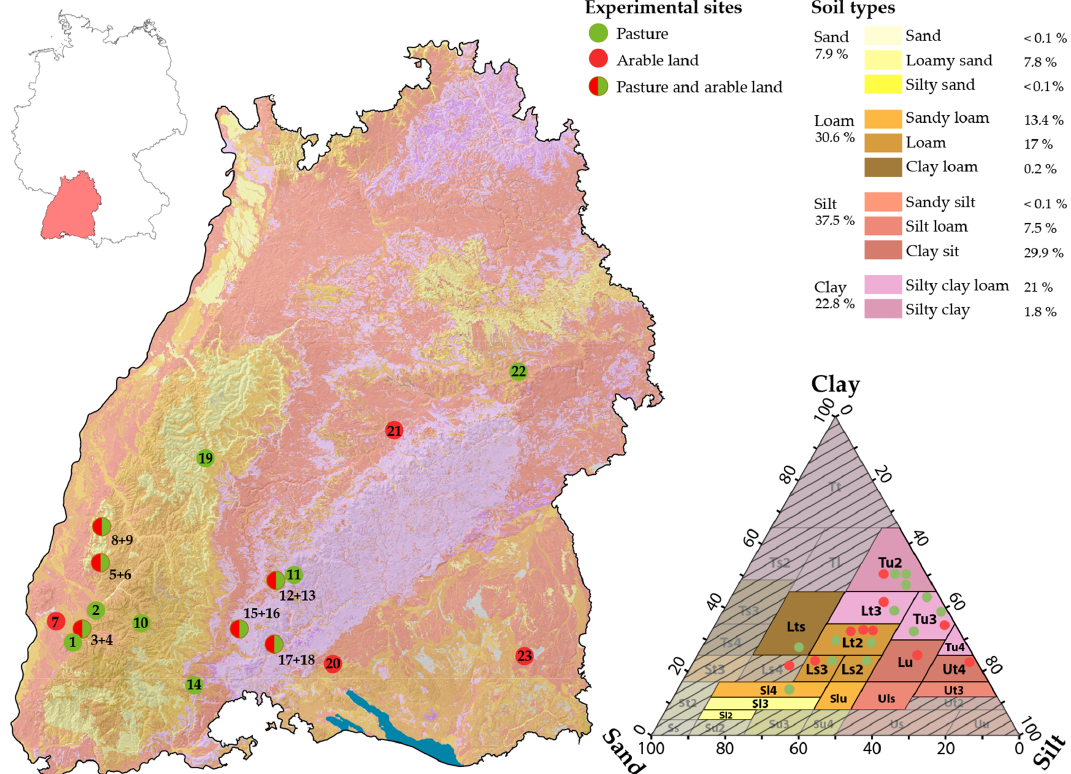
Figure 1. Location of experimental sites and distribution of soil types in the federal state of Baden-Württemberg according to the soil map BK50 (LGRB, 2017). Site textures in the soil texture triangle (German soil texture classes; Ad-hoc Arbeitsgruppe Boden, 2005) are shown according to particle size measurements in the laboratory. The hatched areas represent soil types not common in the federal state of Baden-Württemberg according to the soil map